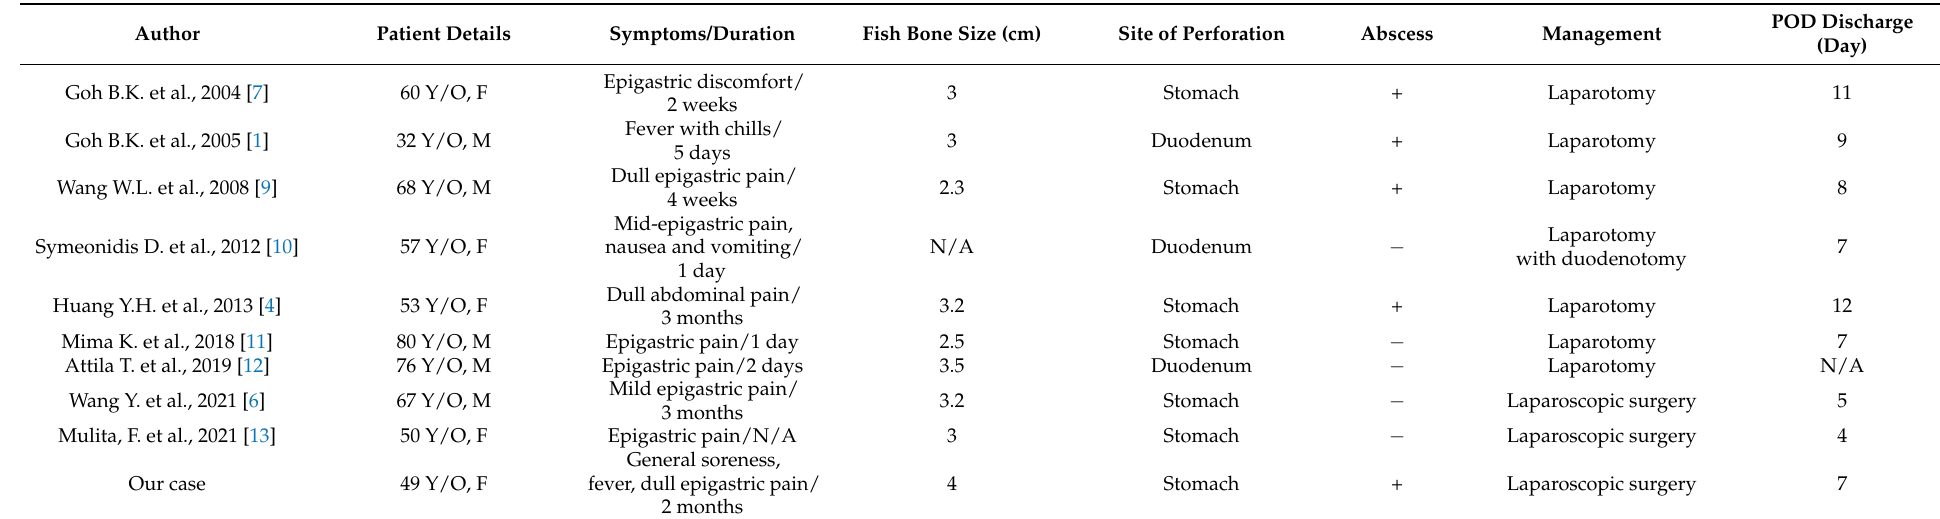
Table 1. Reported cases of pancreatic injury due to penetration by ingested fish